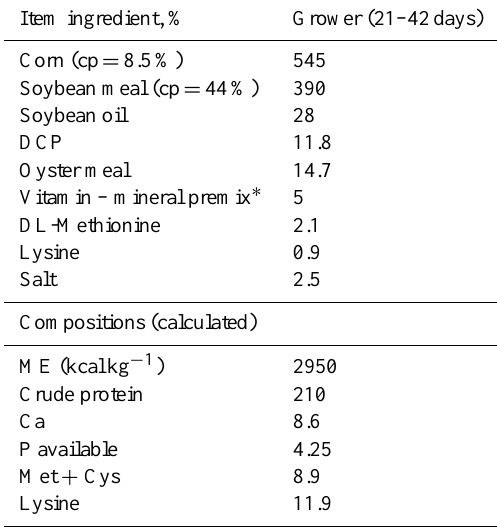
Table 1. Ingredients and nutrient specifications of experimental di- ets (gkg − 1